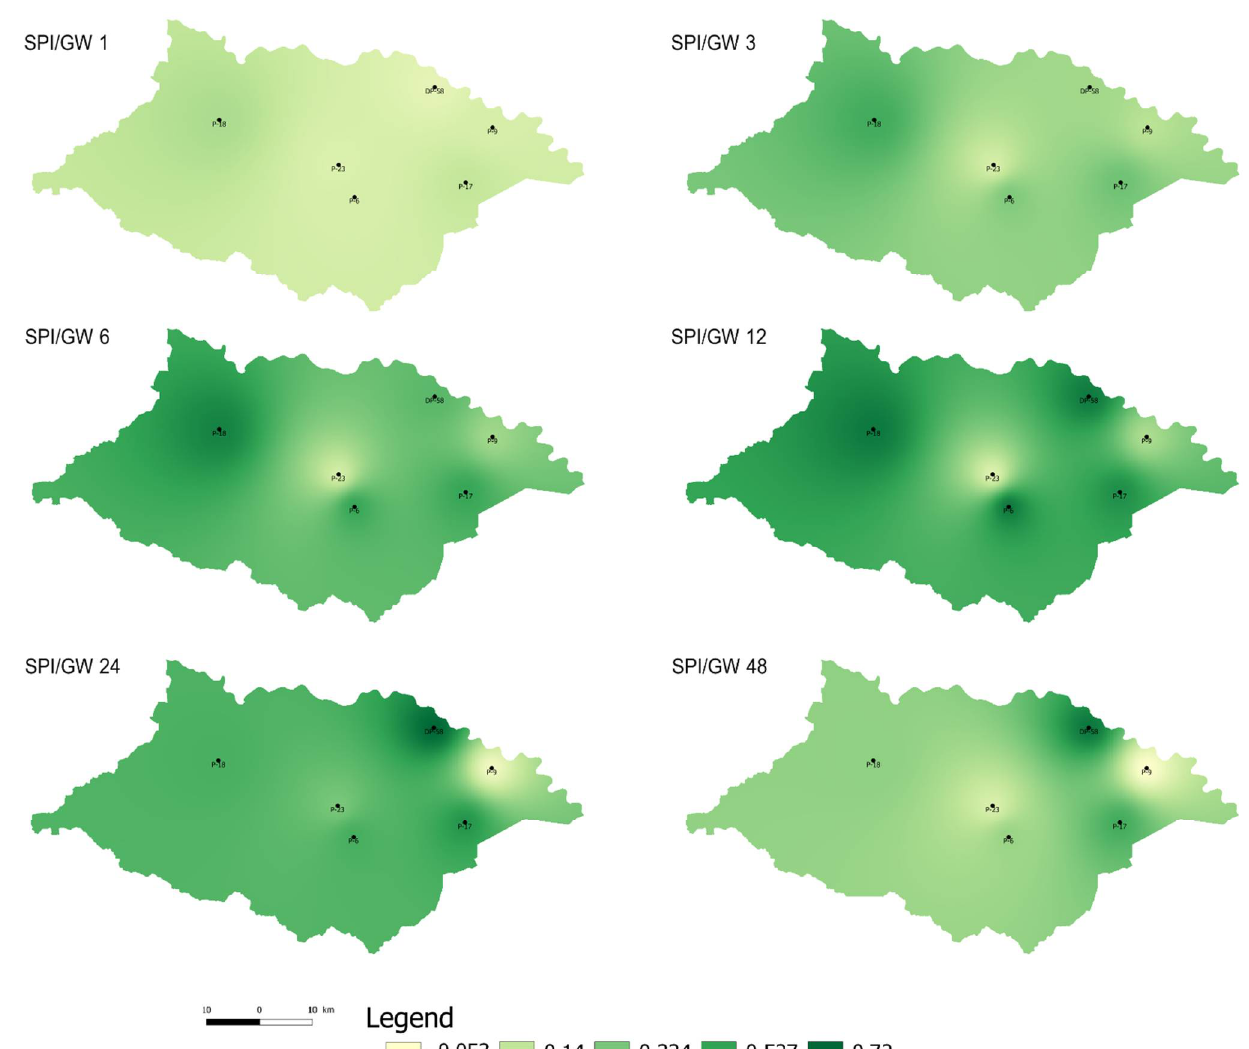
Figure 9. Spatial distribution of SPI/GW correlation over different time scales.